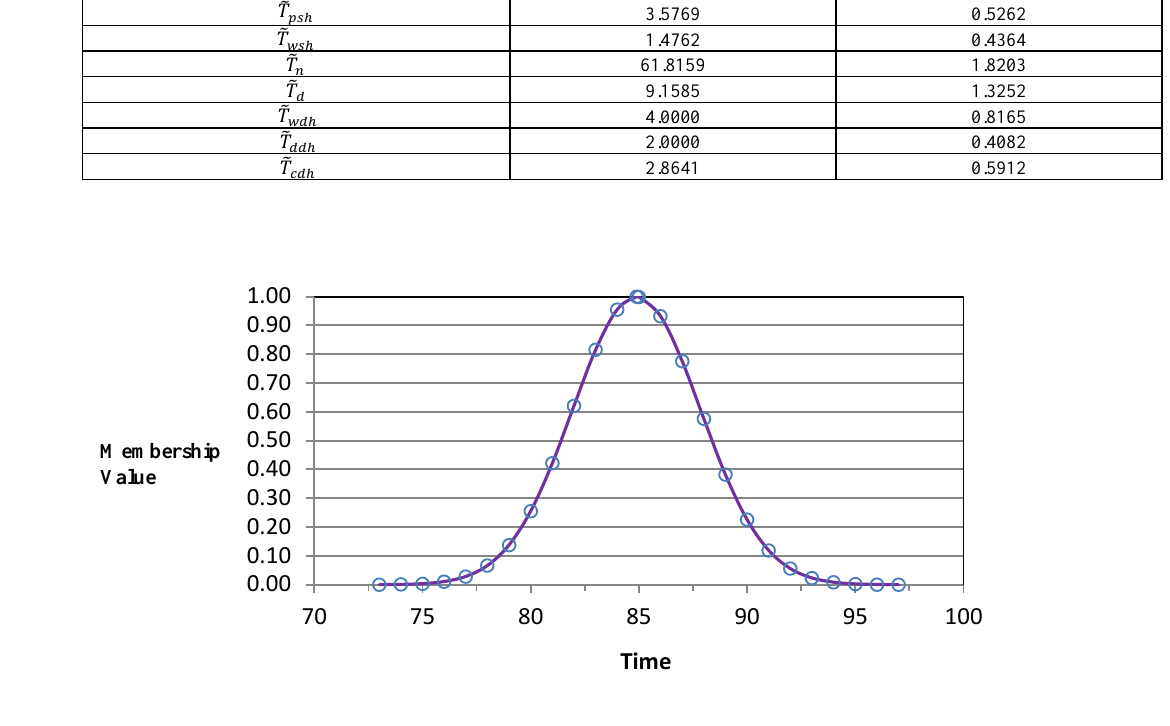
Figure 4. Gaussian membership function of travel time.